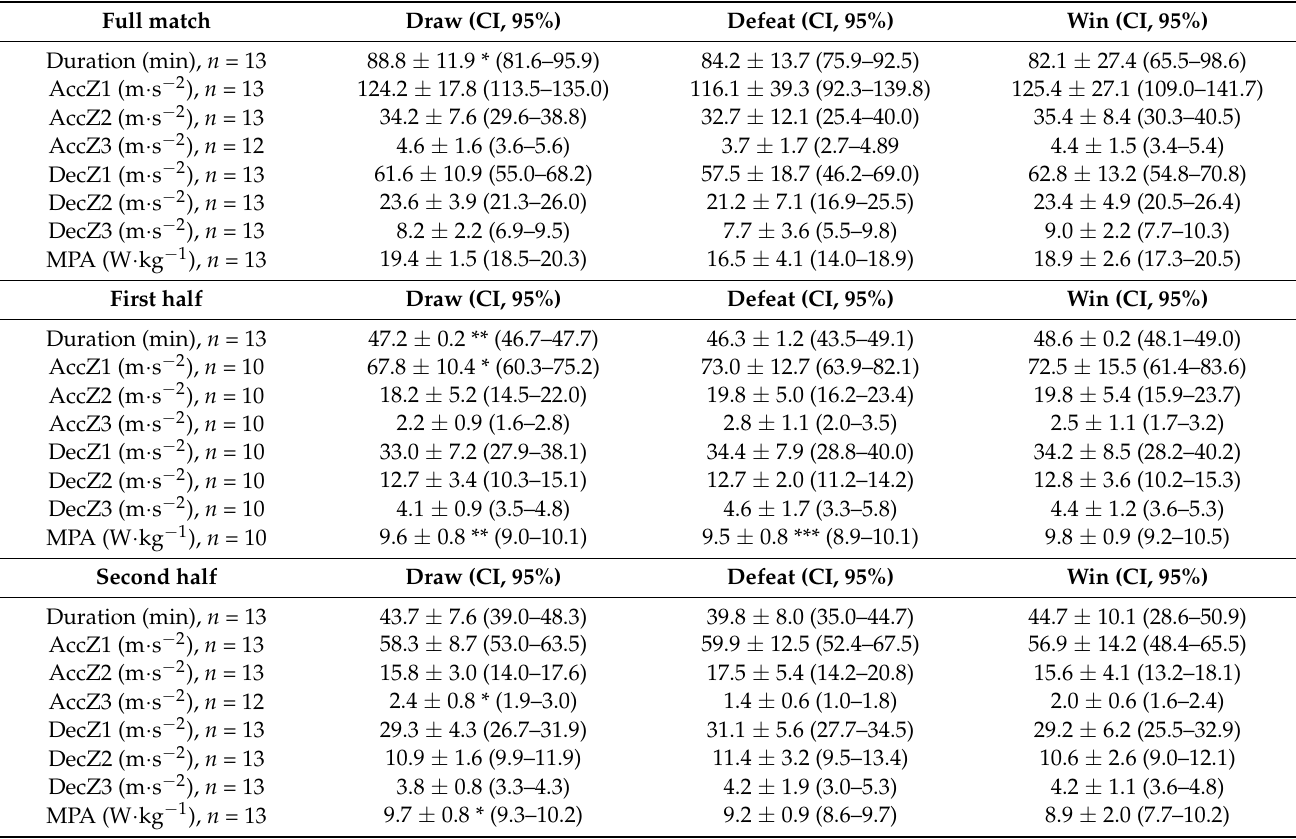
Table 2. Comparison of full match-day, first and second half data between wins, draws and defeats per squad average, mean ± standard deviation (confidence interval, CI, 95%).